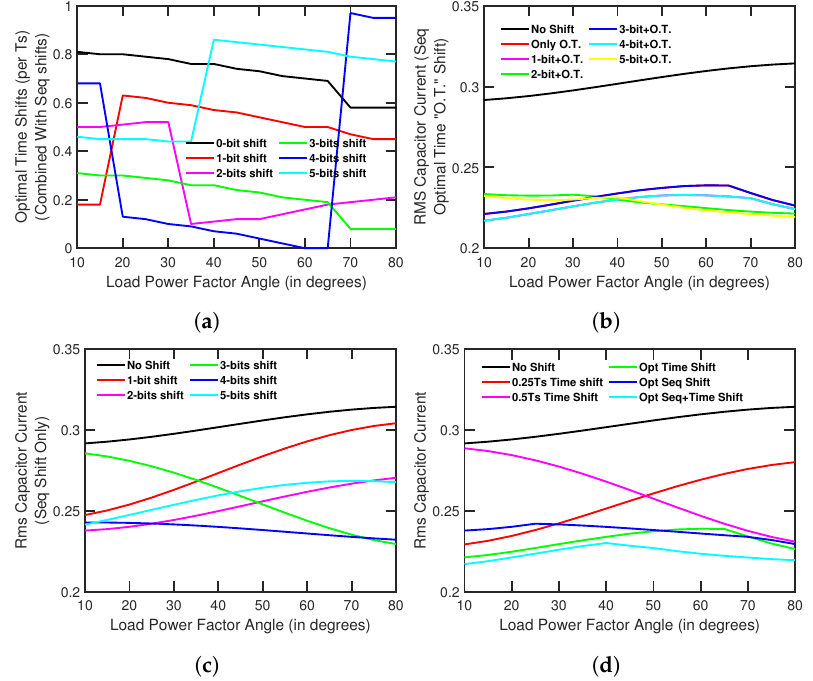
Figure 11. For load 1 at mod.index = 1, and load 2 at mod.index = 0.7. ( a ) Optimal time shifts (com- bined with seq shifts). ( b ) i c,rms for seq+opt time shifts. ( c ) i c,rms for only seq shifts. ( d ) Comparative i c,rms for different interleaving